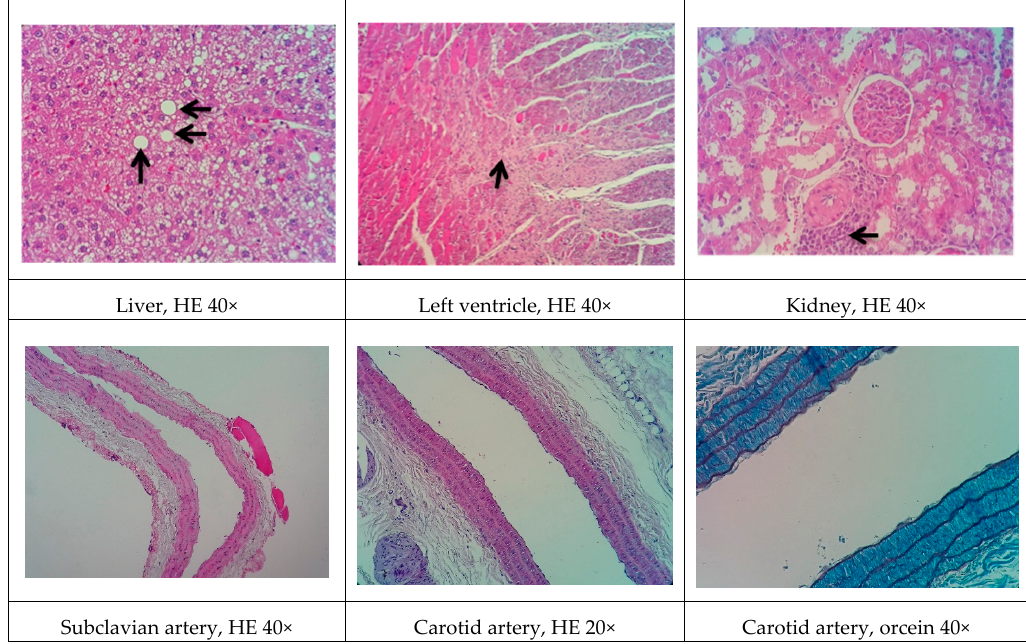
Figure 4. Representative cross-sections of the liver, left ventricle, kidney, and subclavian and carotid arteries in the LOAD group. Black arrows indicate cardiac fibrosis, lipid macrovesicles in the liver, and inflammatory infiltrate in renal tissue. HE, hematoxylin-eosin staining; LOAD, normotensive and ovariectomized rats that received the atherogenic diet, methimazole, cholecalciferol, and l